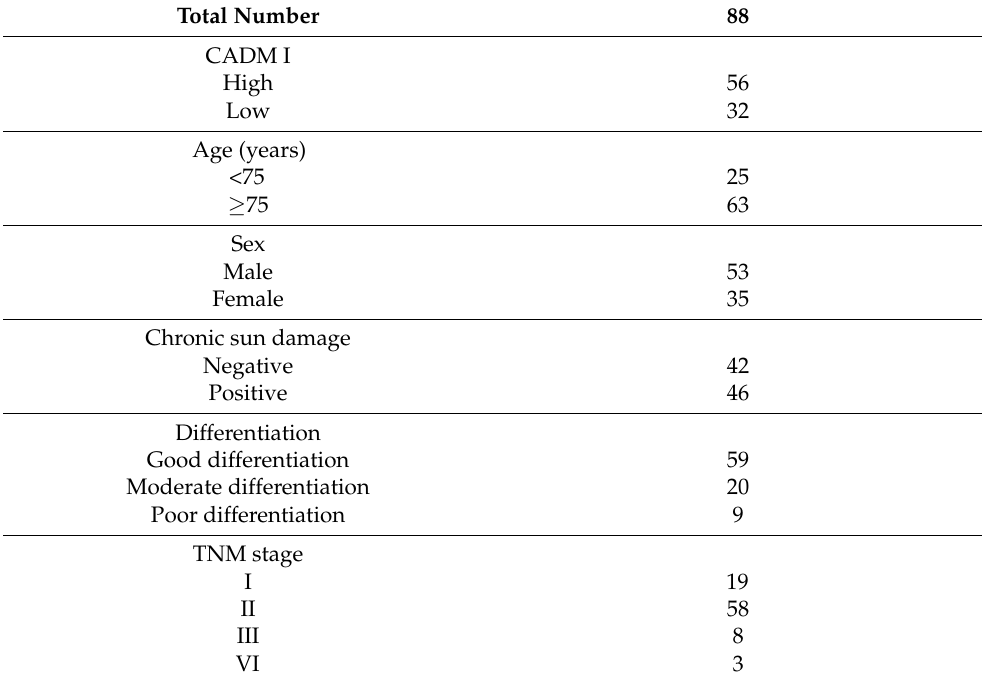
Table 1. Clinical